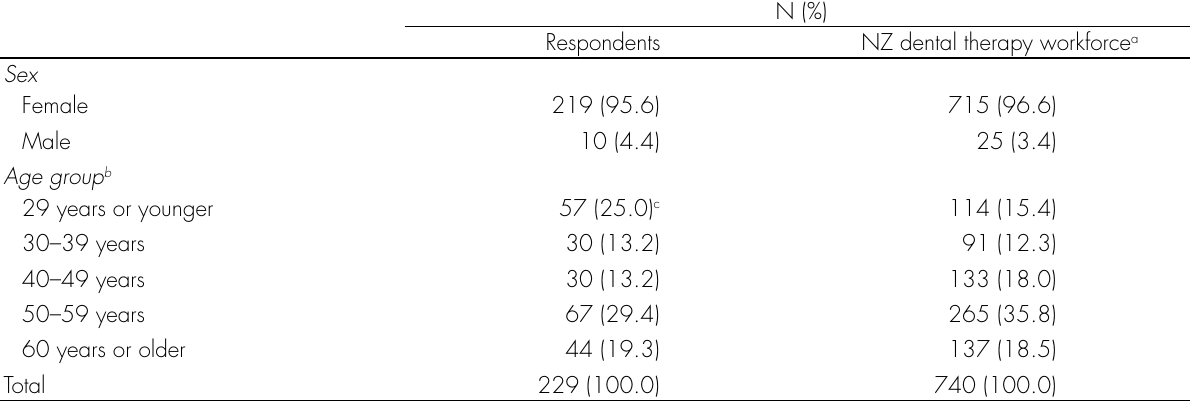
a Data obtained from DCNZ Workforce Analysis 2010; b age data not available for one respondent; c p <